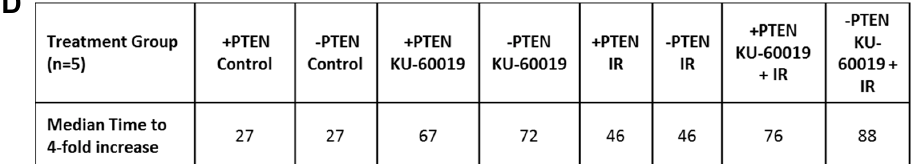
Figure 6. Anti-tumor response to combinations of radiation with KU-60019 and its dependency on PTEN status. ( A ) Relative tumour volume curves for PC-3 +PTEN and − PTEN subcutaneous xenografts following treatment with KU-60019, IR, or combined KU-60019 + IR treatment. Mean relative tumour volume is plotted against time from initial treatment. KU-60019 was administered at 100 mg/kg for 5 consecutive days when tumours reached 100 mm 3 . Irradiation of tumours was performed as a single dose fraction of 2 Gy. Data represent the mean ± SD of 6 mice in each group. ( B ) Statistical analysis (T-test) between different tumour volumes at day 30. ( C ) Kaplan–Meier graph (percentage animals at target volume plotted against time) for treatment groups in A. Significance between treatments was analysed by the log-rank test (Mantel–Cox). p = <0.05 is considered statistically significant. ( D ) Median survival (days to reach 4-fold increase in initial tumour volume) for xenograft treatment groups.